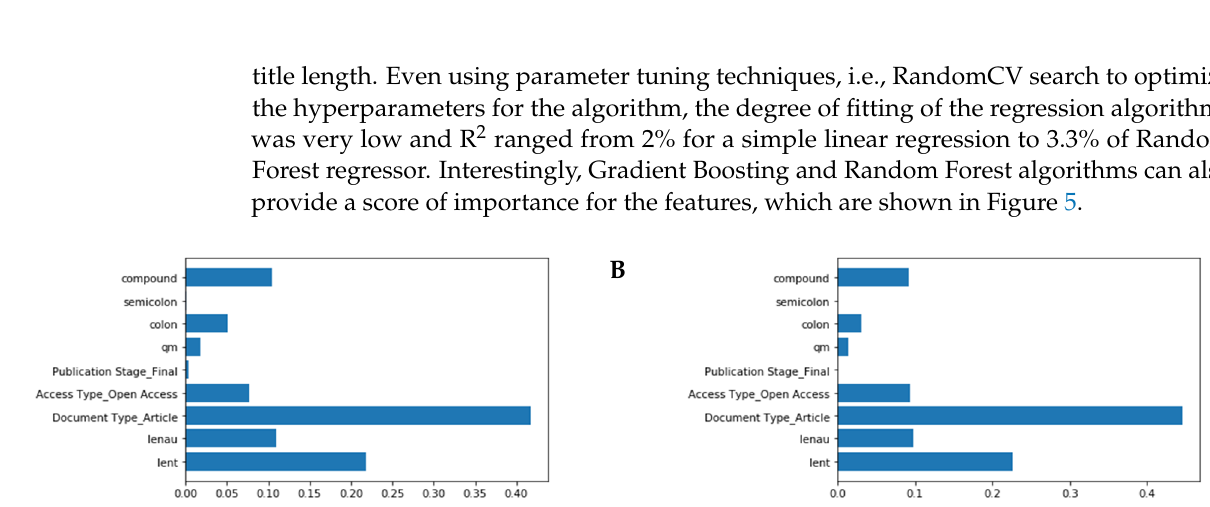
Figure 5. Feature importance for ( A ) GradientBoost regressor and ( B ) Random Forest regressor.